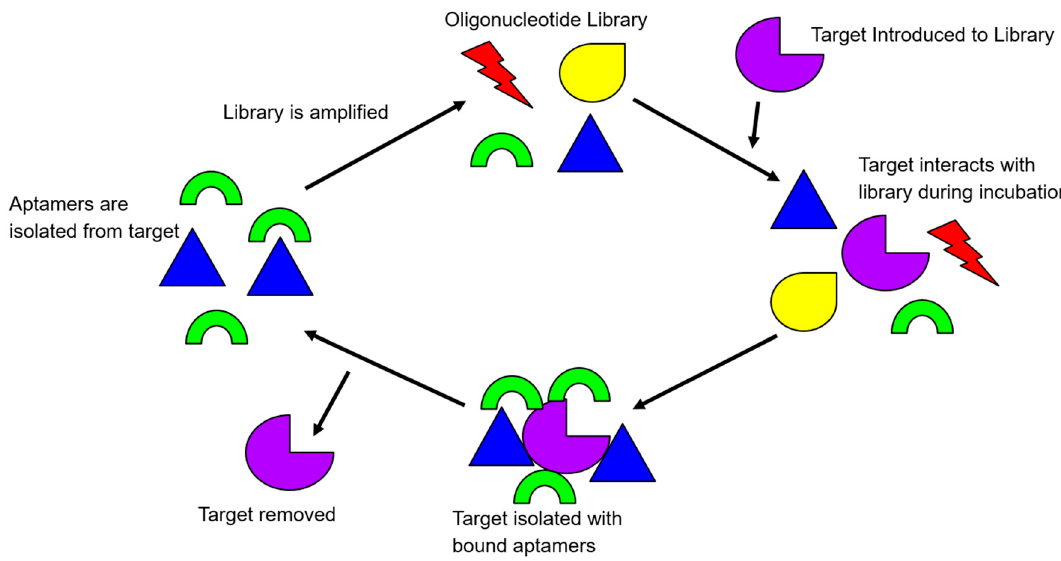
Figure 1. An illustration of the rudimentary principle of the Systematic Evolution of Ligands by Exponential Enrichment (SELEX) process. Target-bound library molecules are subjected to repeated cycles of incubation, partitioning, and amplification, to increase the library affinity for the